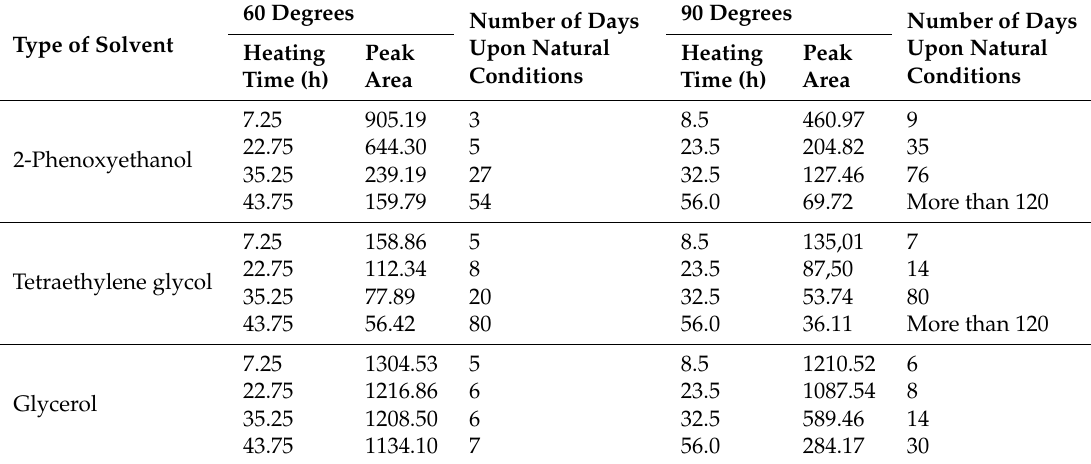
Table 7. Comparison of heating time at different temperatures and storage time under natural conditions with chromatographic parameters obtained for writing inks of different